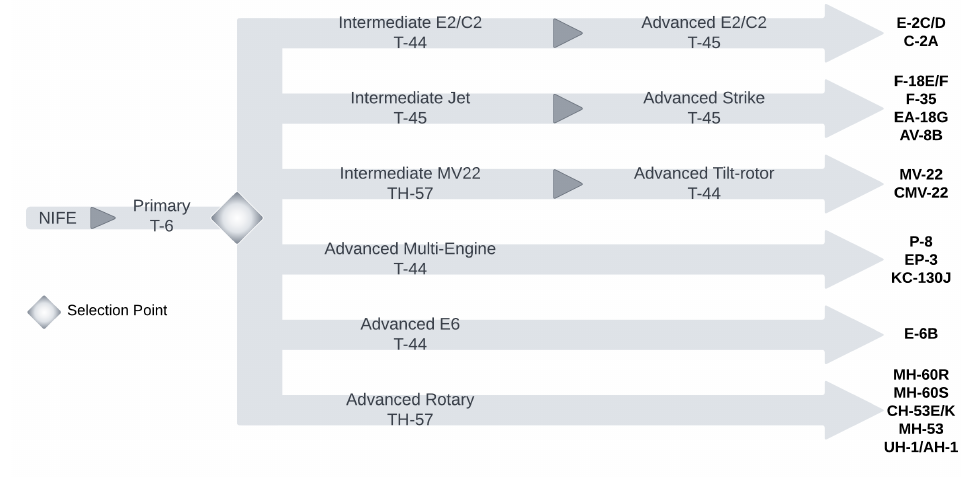
Figure 1. CNATRA’s six student navy aviator training pipelines [2].